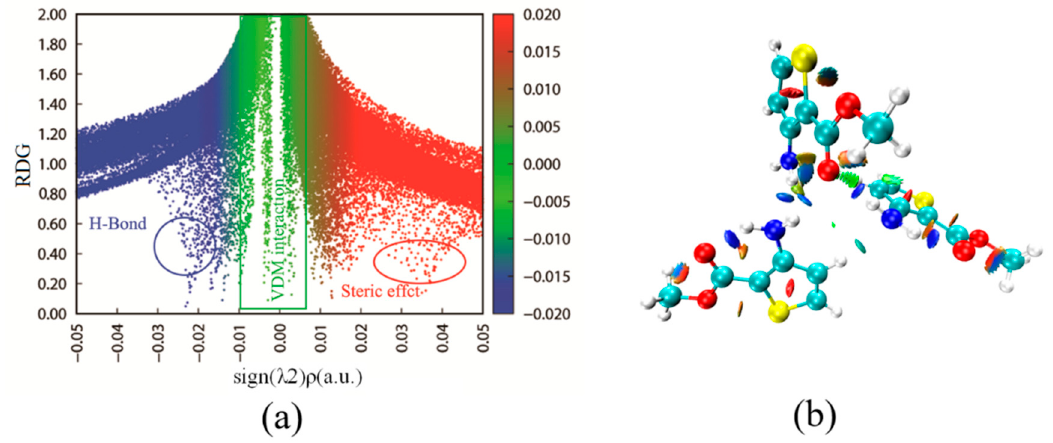
Figure 6. ( a ) The scatter graph; ( b ) the corresponding color-filled gradient isosurfaces map of the matc trimer structure.